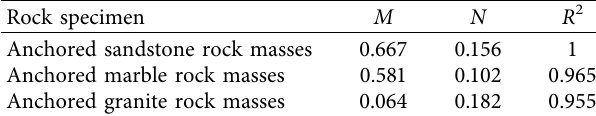
Table 3: Related parameters of the fitting curve. Rock specimen